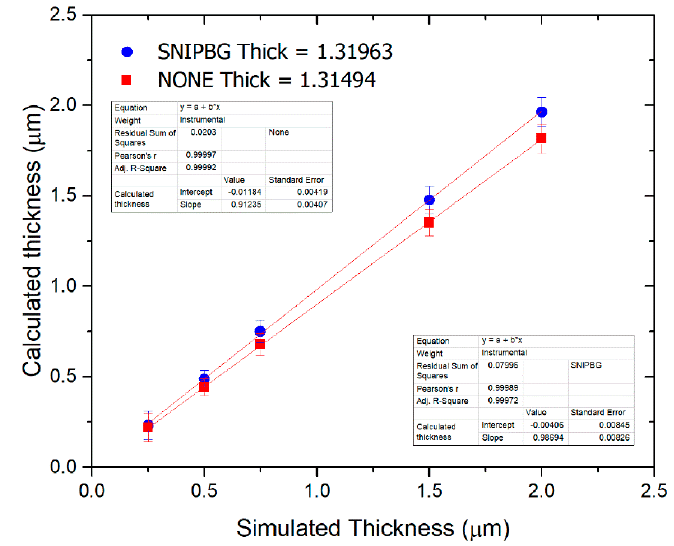
Figure 5. Influence of background contribution in the thickness calculation for various simulated gold leaves applied to a lead white substrate. Thick values on the top left corner represent the measured matrix thick ratio for the substrate with and without the continuum contribution.